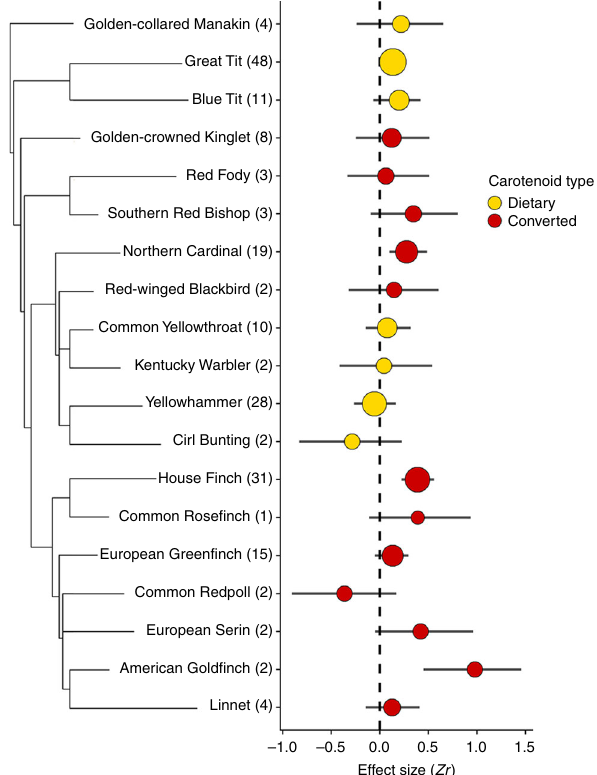
Fig. 3 The contribution of each species to the overall relationship between feather color richness and measures of individual quality. Number of effect sizes per species are in parentheses. Circles represent weighted mean correlation (Zr) effect sizes for species with plumage coloration from converted (red) and dietary carotenoids (yellow). Circle size is inversely proportional to the variance of the mean effect size. Horizontal lines represent 95% credible intervals. Effect size estimates with credible intervals that do not include zero are statistically signi fi cant effects ( α